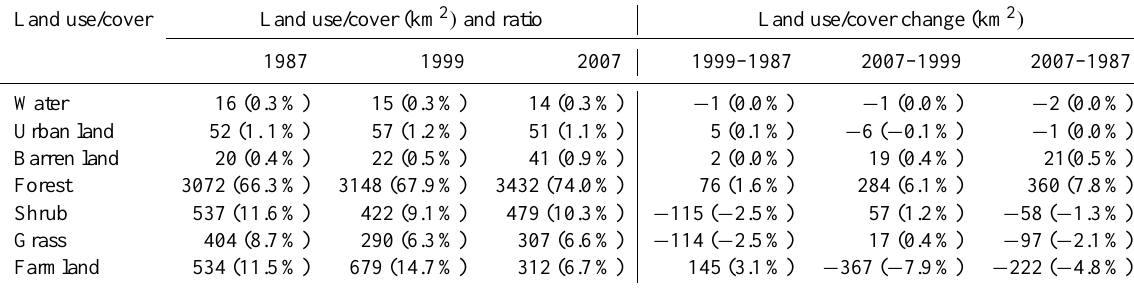
Table 2. Land use/cover and change ratio during 1978–2007 in the Xinzhou catchment. Land use/cover